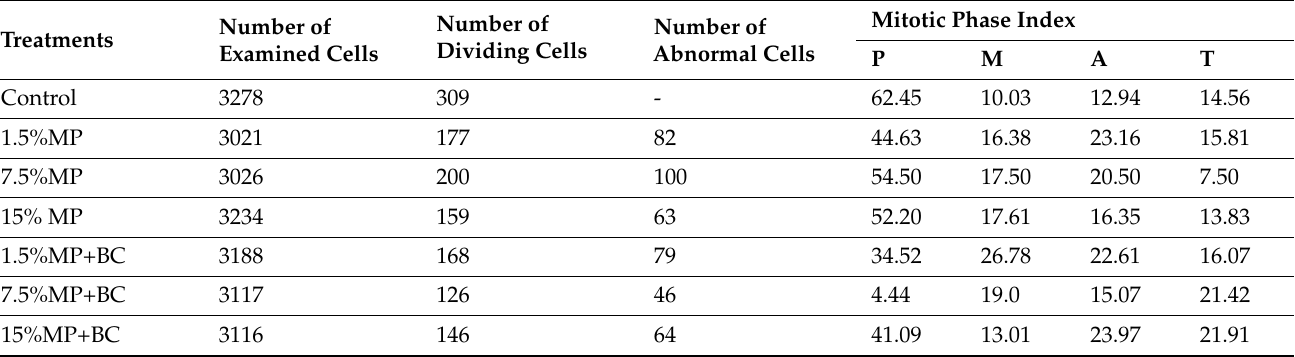
Table 6. Cytological indicators of examined root tips of Vicia faba affected by biochar after microplastic addition to